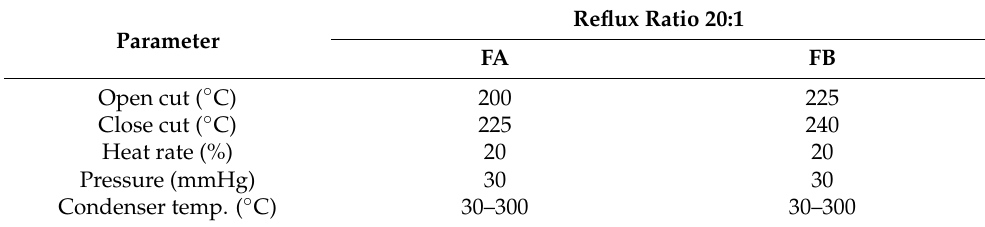
Table 1. The Operational conditions of fractional Vacuum distillation.